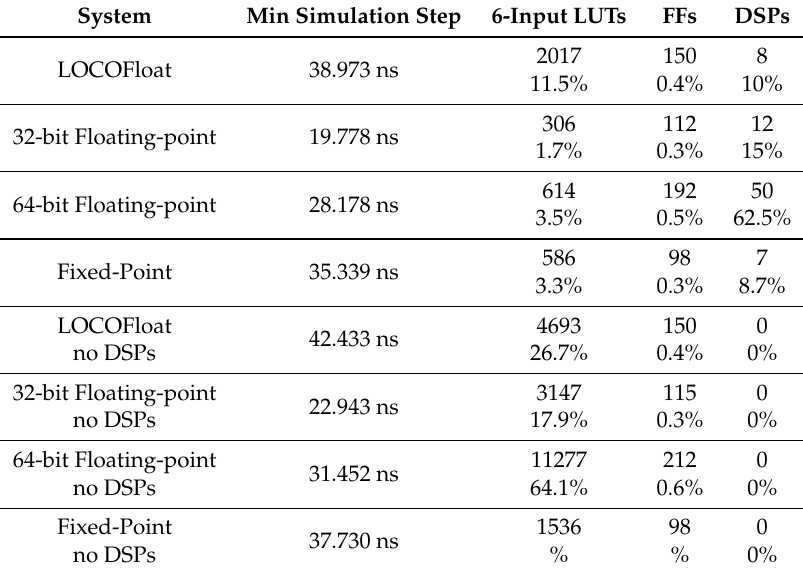
Table 3. FPGA (Xilinx XC7Z010-1CLG400C) resources used by the design, and percentage value with respect to the available resources in the FPGA.